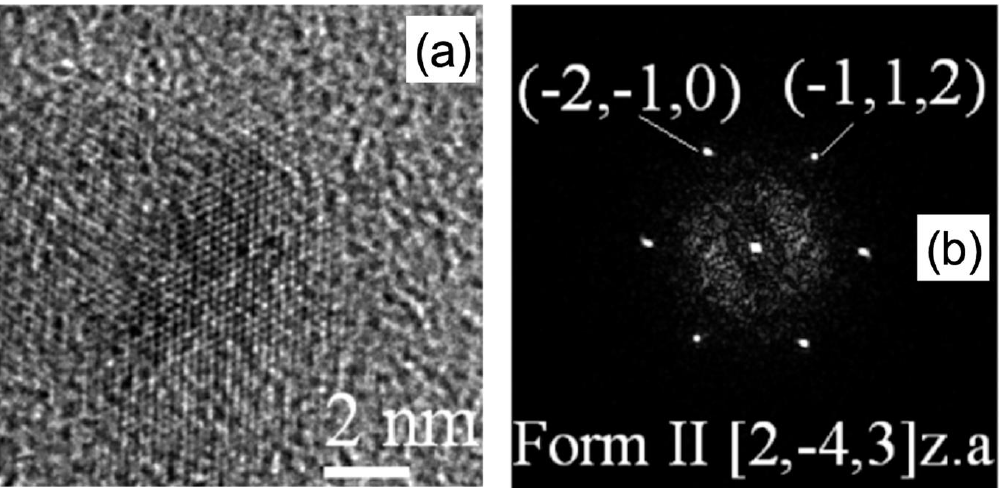
Figure 9. ( a ) HRTEM image of a caffeine (CAF) glutaric acid (GLA) polytype II [5] particle along with ( b ) the relevant diffractogram (reprinted by courtesy from Hasa et al. [5]) .